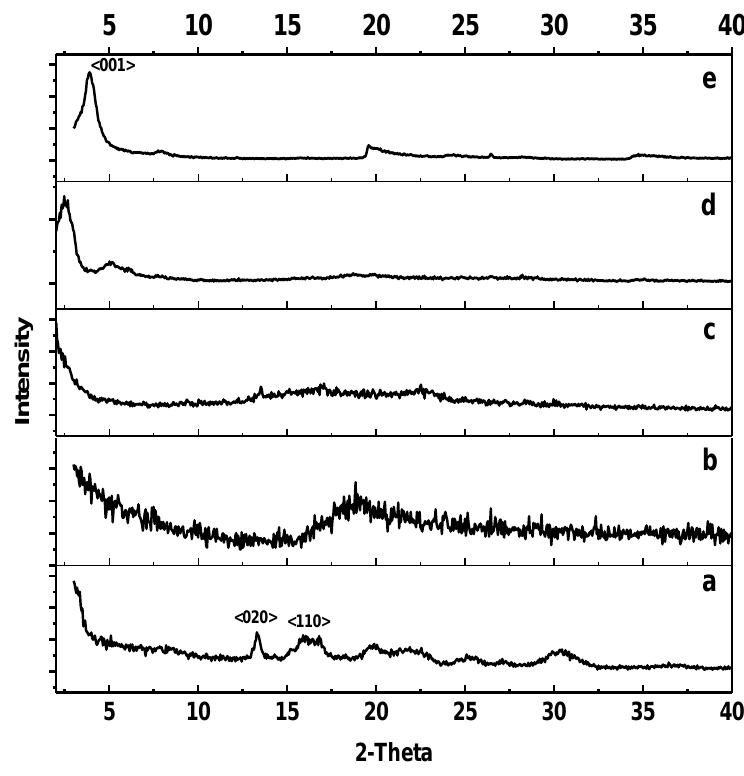
Figure 3. XRD patterns of ( a ) PHB; ( b ) ENR-50; ( c ) PHB/ENR-50 (50/50)